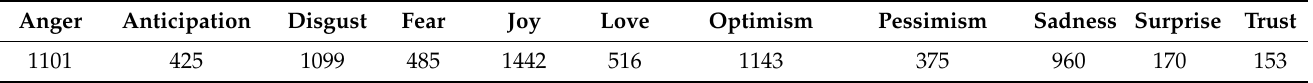
Table 2. Number of occurrences of the tested emotions in the samples of the training dataset.